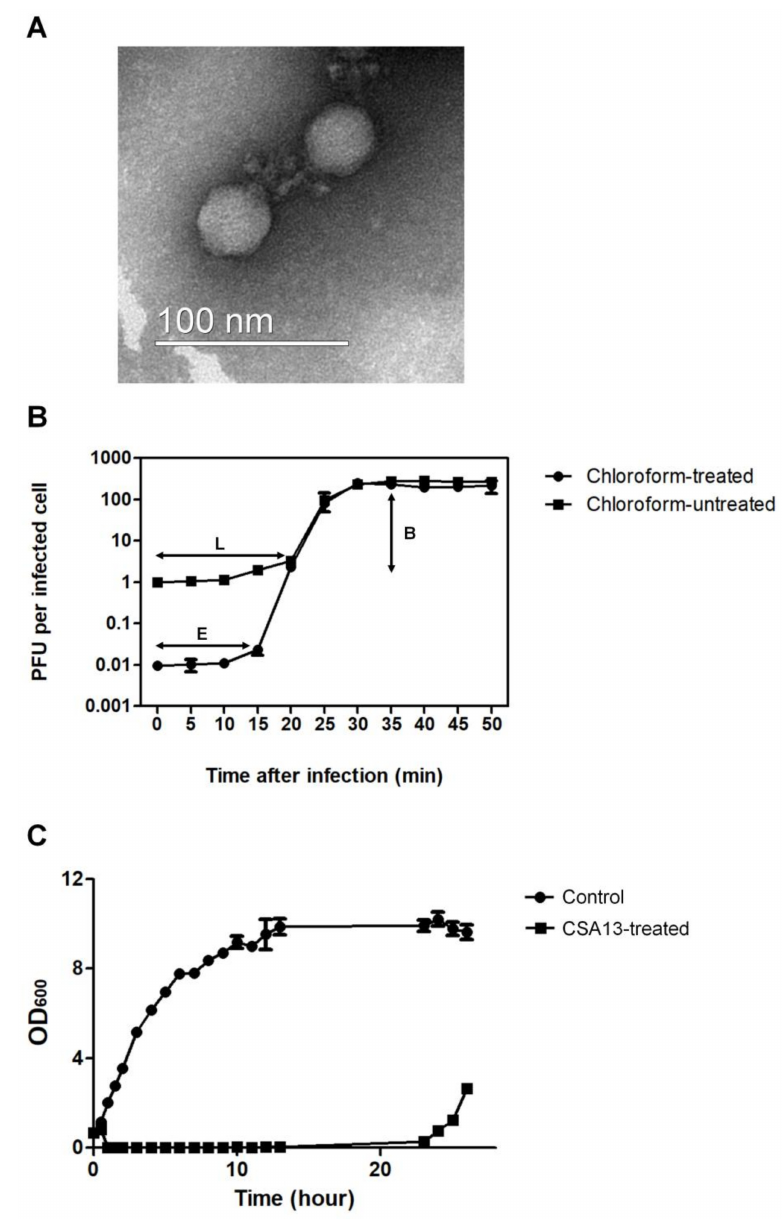
Figure 1. General characterizations of phage CSA13. ( A ) Electron micrograph of phage CSA13, which belongs to the Podoviridae family. The scale bar represents 100 nm. ( B ) One-step growth curve analysis of phage CSA13 on an exponential culture of S. aureus clinical isolate FMB-1 incubated in tryptic soy broth (TSB) medium at 37 ◦ C, with shaking at 220 rpm. The culture of S. aureus clinical isolate FMB-1 was divided into two groups; chloroform-treated ( • ) or untreated ( (cid:4) ). E, eclipse period; L, latent period; B, burst size. ( C ) Inhibition assays of S. aureus clinical isolate FMB-1 with phage CSA13 at 37 ◦ C, with shaking at 220 rpm. Cells were prepared in two groups: control group without phage ( • ) or experimental group with phage CSA13, at an MOI of 1 ( (cid:4) ). The data shown are the mean values from three independent measurements, and the error bars represent the standard